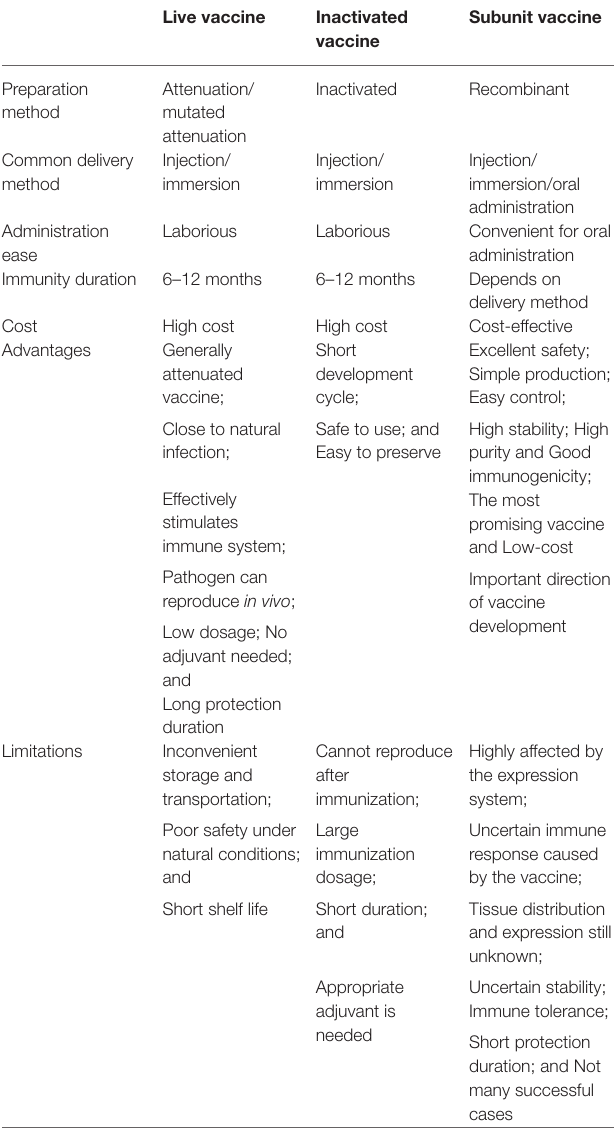
TABLE 1 | Comparison of three types of vaccines and delivery methods. Live vaccine Inactivated